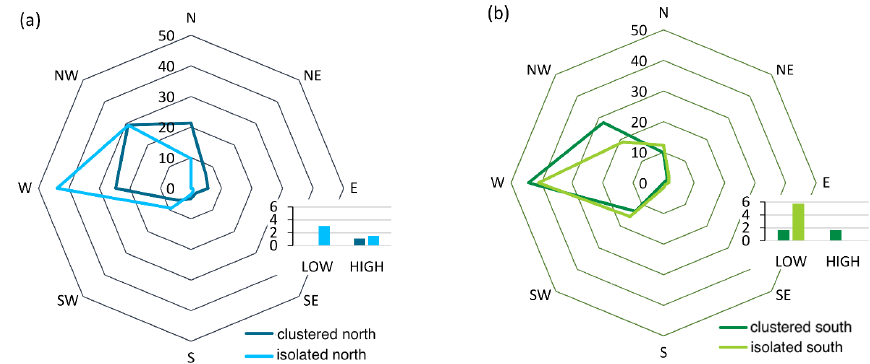
Figure 4. Relative frequency [%] of weather types per hail day category for hail events (a) north of the Alps and (b) south of the Alps. The eight directional weather types are shown in the spider plot, and low- and high-pressure weather type frequencies are indicated in the